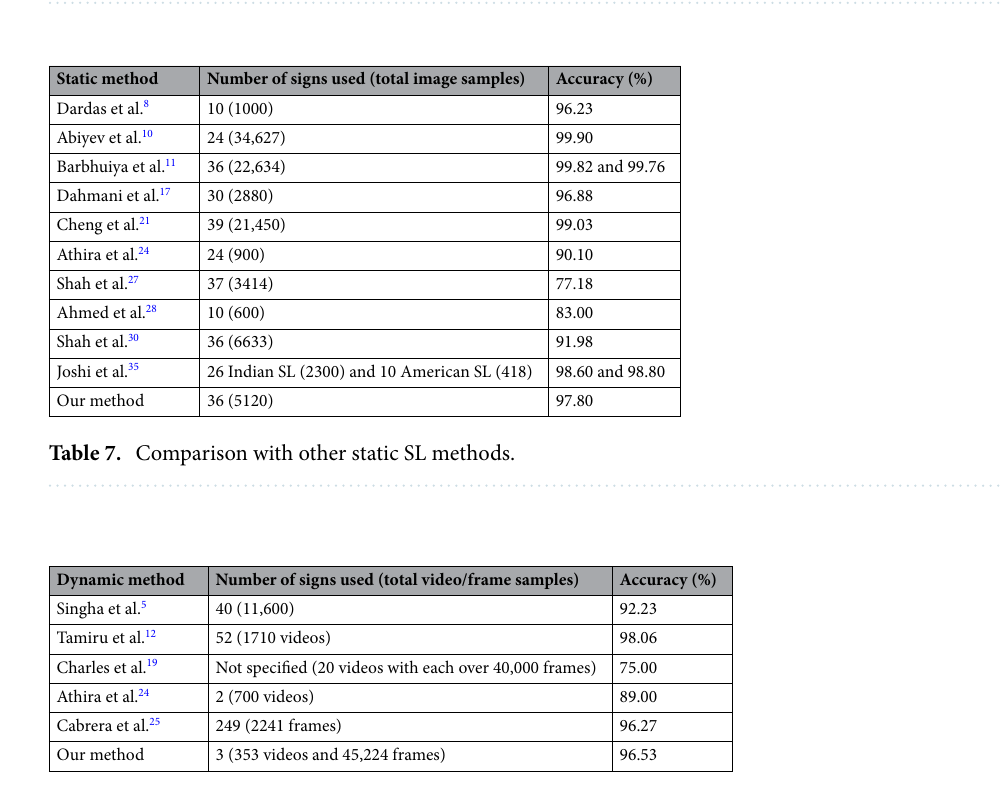
Table 8. Comparison with other dynamic SL